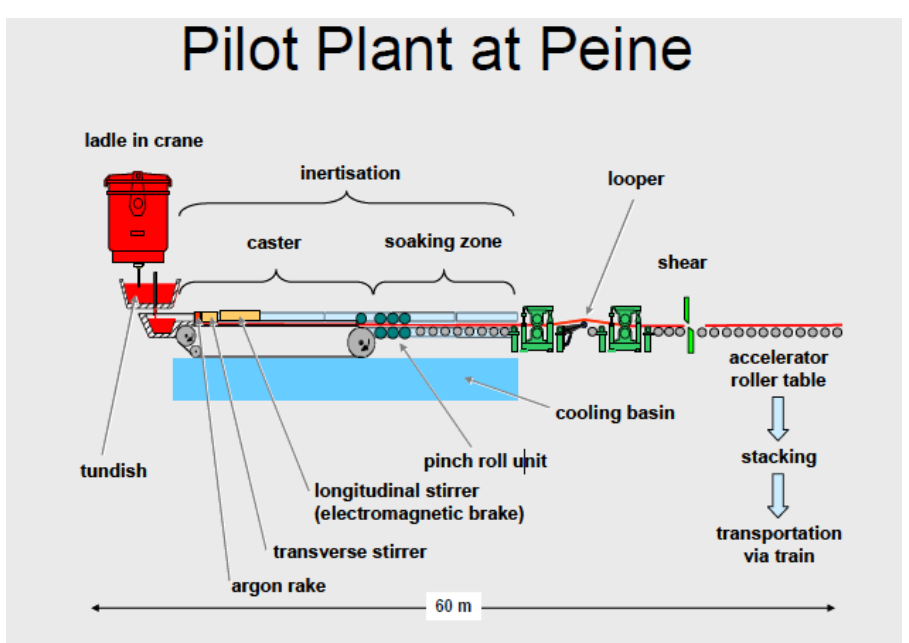
Figure 5. Schematic of the industrial scale pilot plant of Direct Strip Castin (DSC) at Peine, Germany [11].